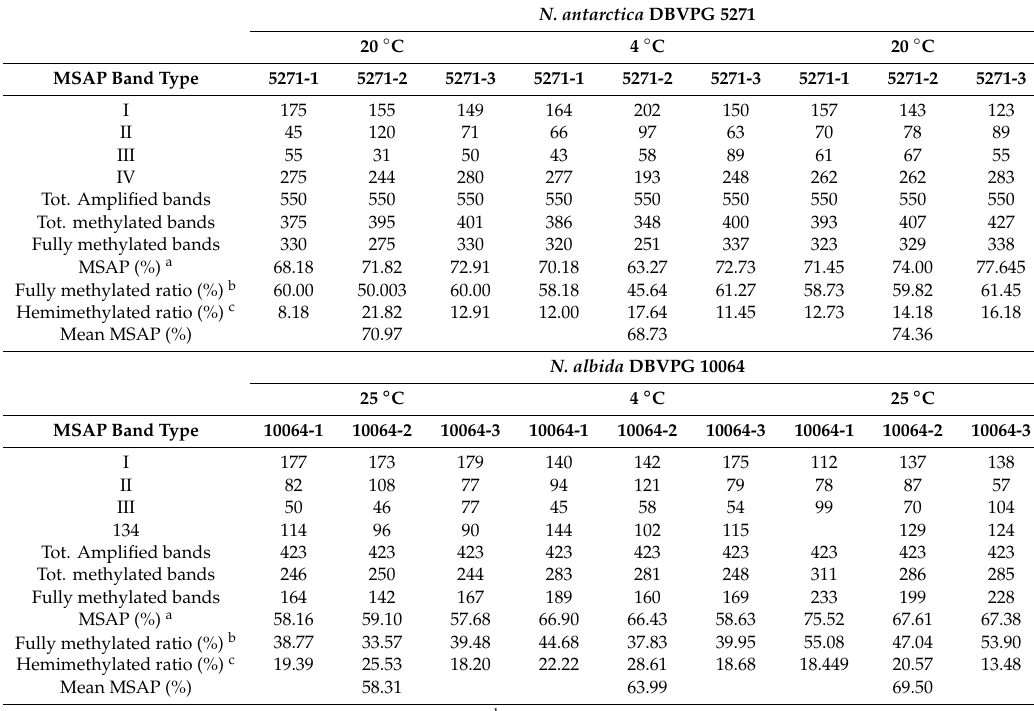
Table 1. DNA methylation changes of N. antarctica DBVPG 5271 and N. albida DBVPG 10064 at di ff erent temperatures: optimum and cold